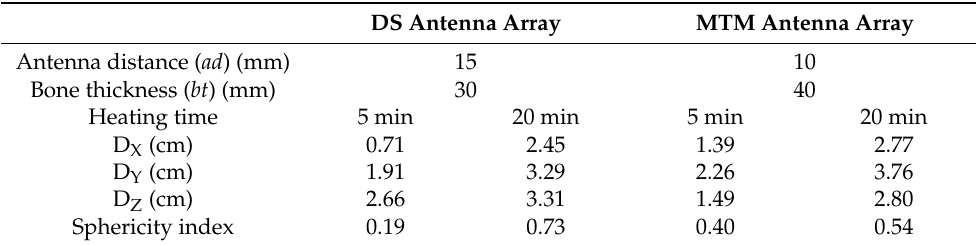
Table 4. Best-case scenarios of ablation zone dimensions for 5 min and 10 min (6 W) for the linear configurations of DS and MTM